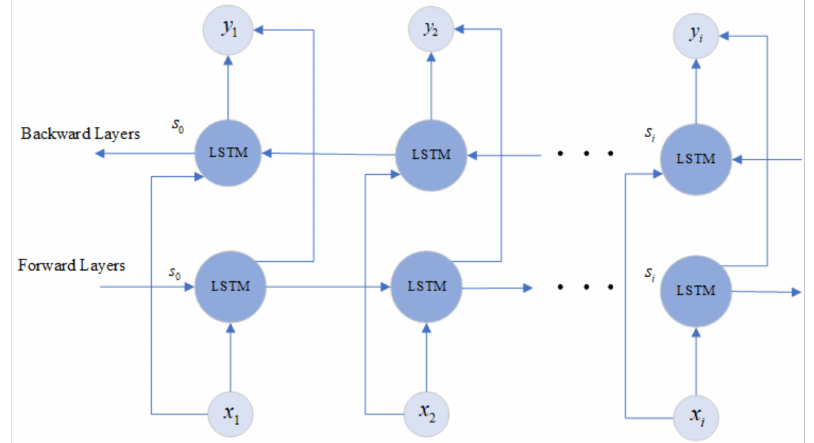
Figure 4. Frame diagram of the BiLSTM.